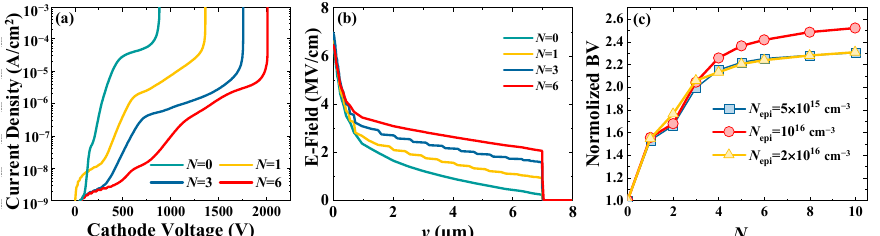
Figure 7. ( a ) As the number of FMRs increases, the breakdown voltage increases initially. ( b ) Vertical electric field profile at the breakdown of the device with different numbers of FMRs. ( c ) The breakdown voltage saturates as the number of FMRs reaches a certain value.